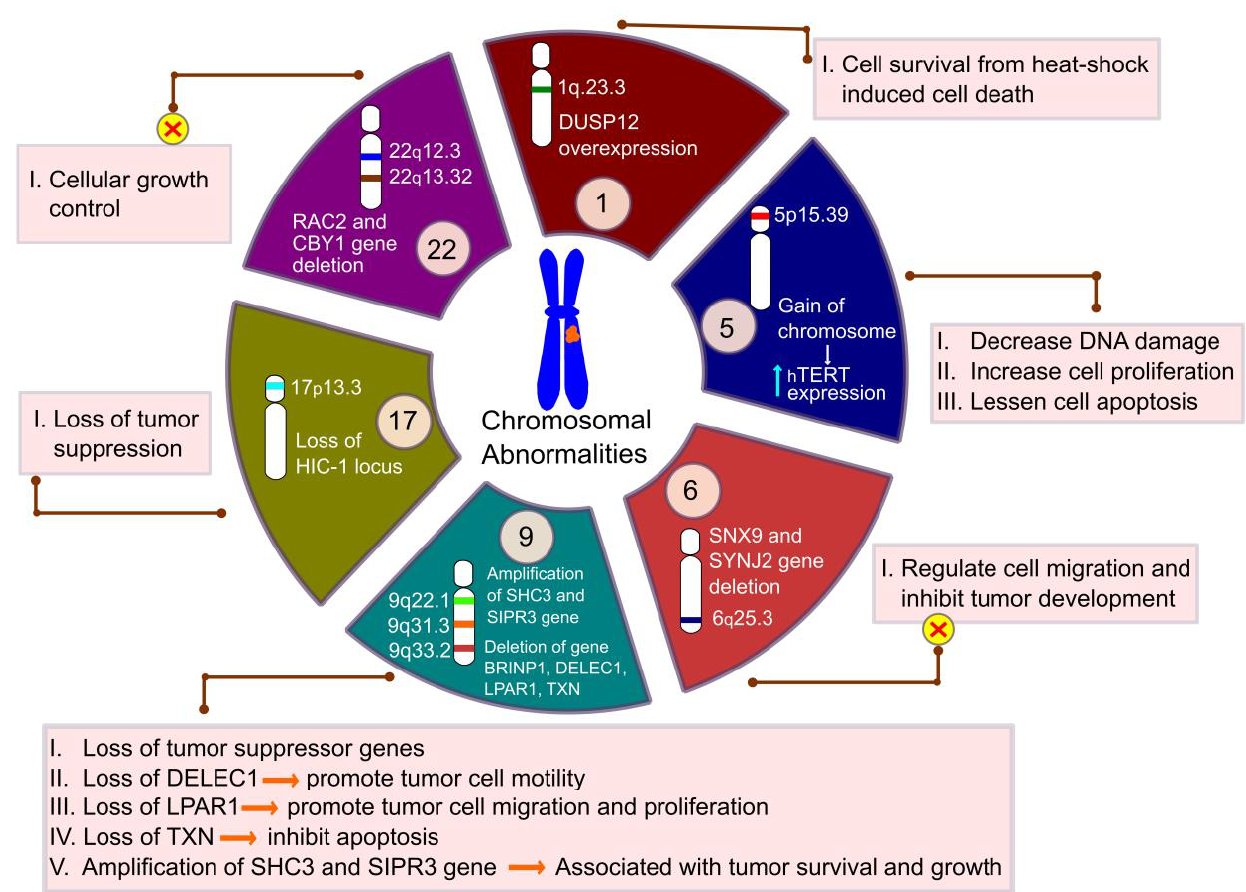
Figure 2. Chromosomal abnormalities in ependymoma. This figure represents the loss or gain of the chromosomal region. Deletion or overexpression of some important genes within those regions plays an important role in tumor formation.